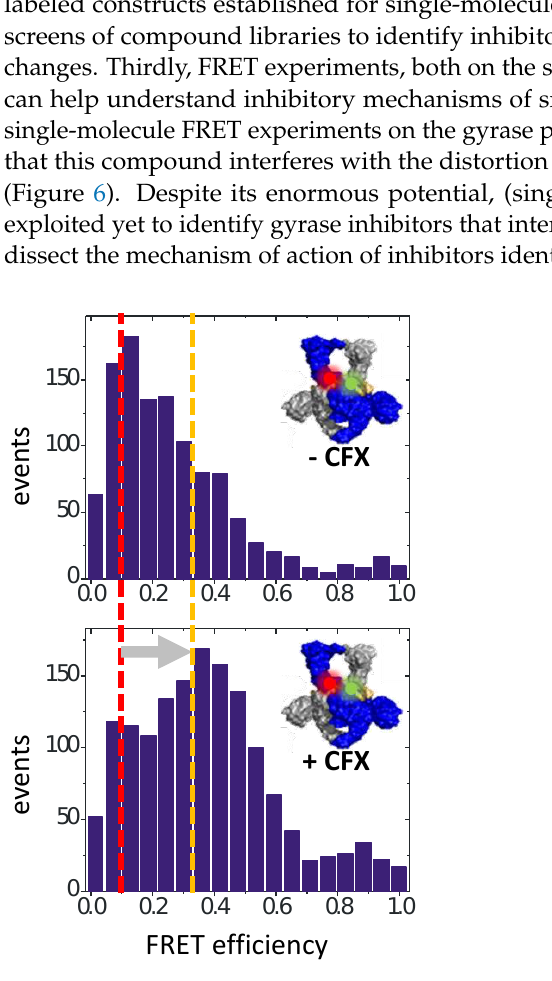
Figure 6. Single-molecule FRET unravels inhibitory mechanisms. Single-molecule FRET histograms of gyrase-bound DNA carrying donor and acceptor fluorophores on opposite sides of the cleavage site. DNA bound to gyrase exists in two conformations, characterized by FRET efficiencies of 0.13 (red line) and 0.3 (orange line; top). The low-FRET state corresponds to DNA that is severely distorted from B-form geometry. Ciprofloxacin (CFX) binding shifts the distribution to the high-FRET species (gray arrow; bottom), indicating that CFX counteracts DNA distortion by gyrase. Such FRET assays can be adapted to screen for inhibitors of conformational changes. Figure modified after Gubaev, A., Hilbert, M., Klostermeier, D. (2009) The DNA-gate of Bacillus sub- tilis gyrase is predominantly in the closed conformation during the DNA supercoiling reaction.